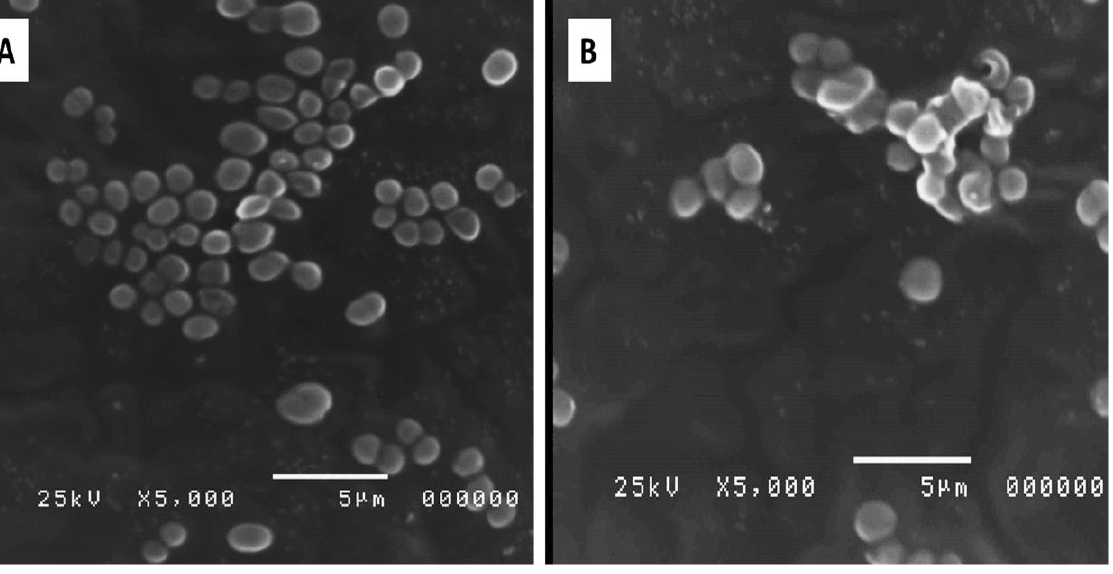
Figure 5. Scanning electron image showing the morphology of a representative A. baumannii isolate (A1): ( A ) before and ( B ) after treatment with SAME.